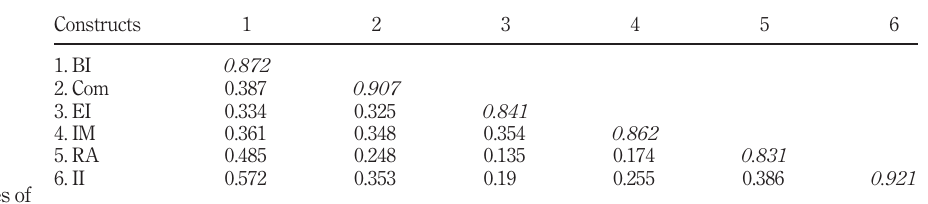
Table 3. Correlation values of